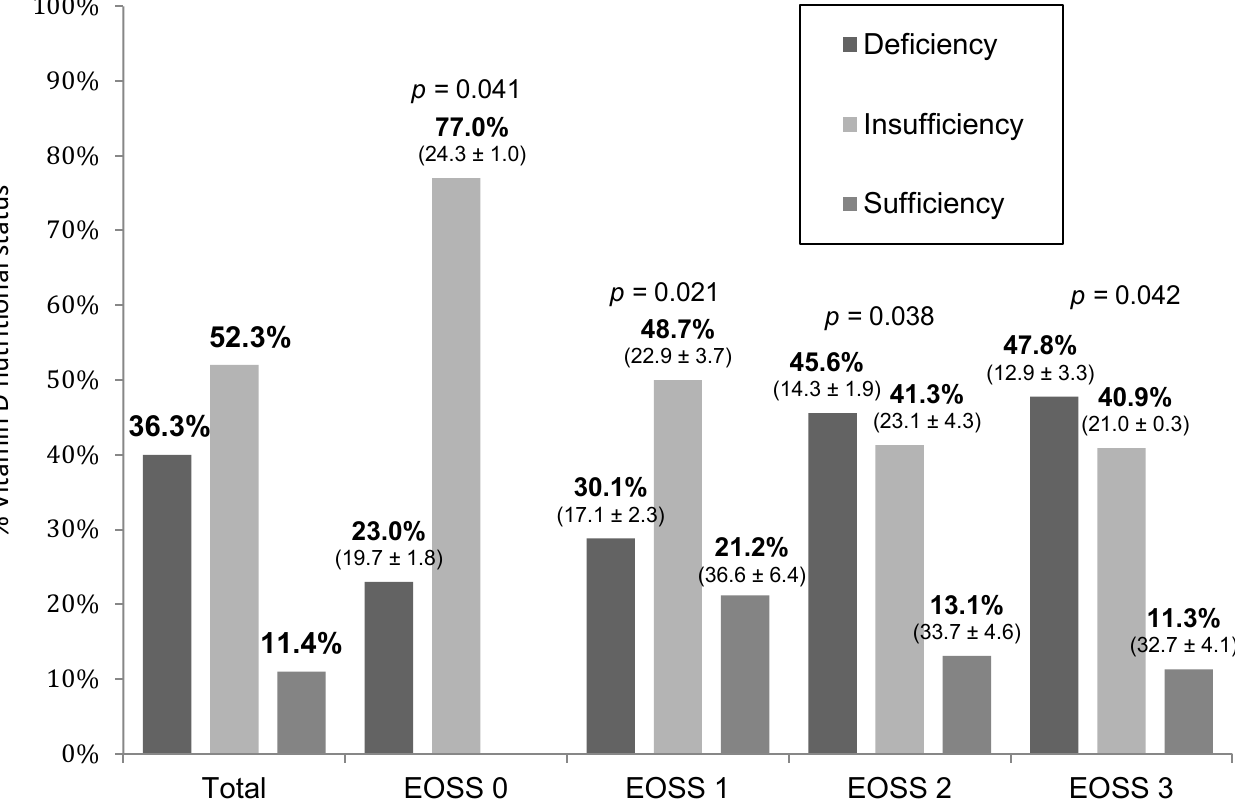
Figure 2. Percentage and mean/standard deviation (ng/mL) of serum concentrations of 25(OH)D for each nutritional status of Vitamin D according to the stage of the Edmonton Obesity Staging System (EOSS). ANOVA. EOSS: Edmonton Obesity Staging System.